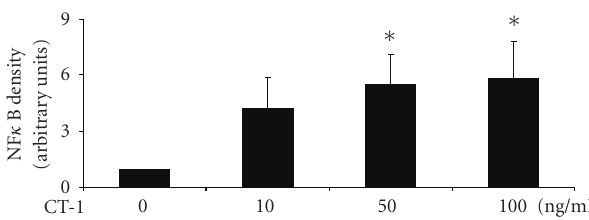
Figure 4: CT-1 causes a concentration dependent increase of NF κ B activity measured by EMSA. Bands corresponding to NF κ B activity were quantified by densitometry and expressed in arbitrary units and normalized to unstimulated PBMC. n = 7, data are expressed as mean ± SEM. ∗ P < . 05 compared to unstimulated